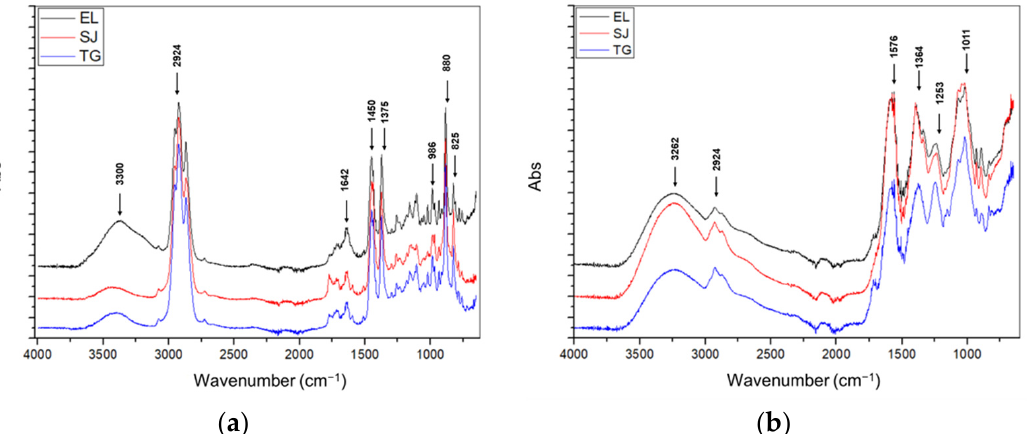
Figure 3. ( a ) IR spectra of the essential oils of F. cernua , ( b ) IR spectra of the purified polyphenolic compounds of F. cernua; Estanque de León (EL), San Jerónimo (SJ), and Tortuga (TG).